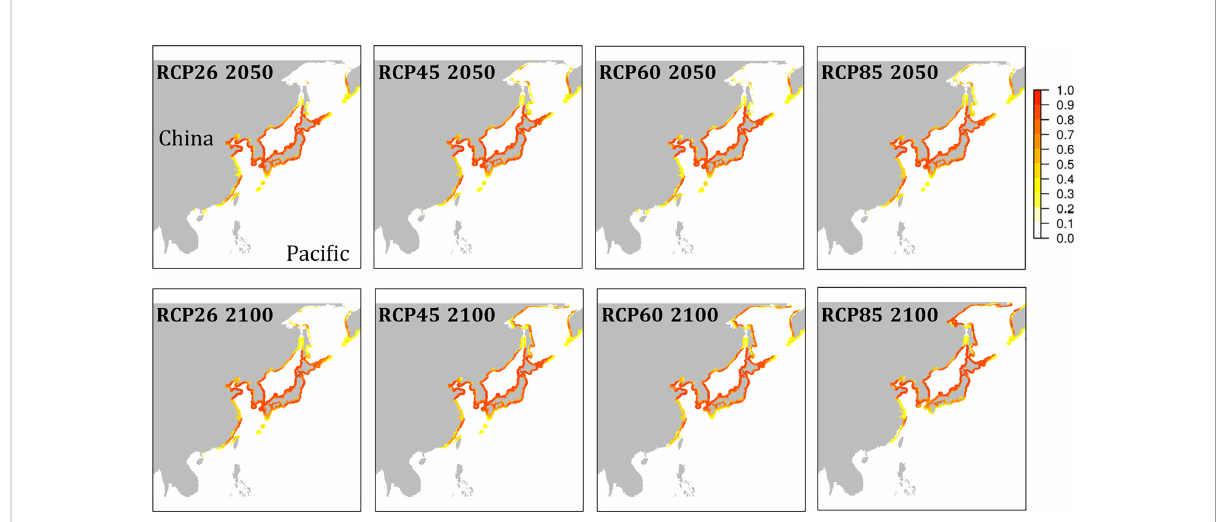
FIGURE 5 Niche model projections of G. vermiculophylla in the northwest Paci fi c. Future habitat suitability by the year 2050 (upper) and by the year 2100 (lower) in cloglog representation under different emission scenarios (RCP26, RCP45, RCP60, and